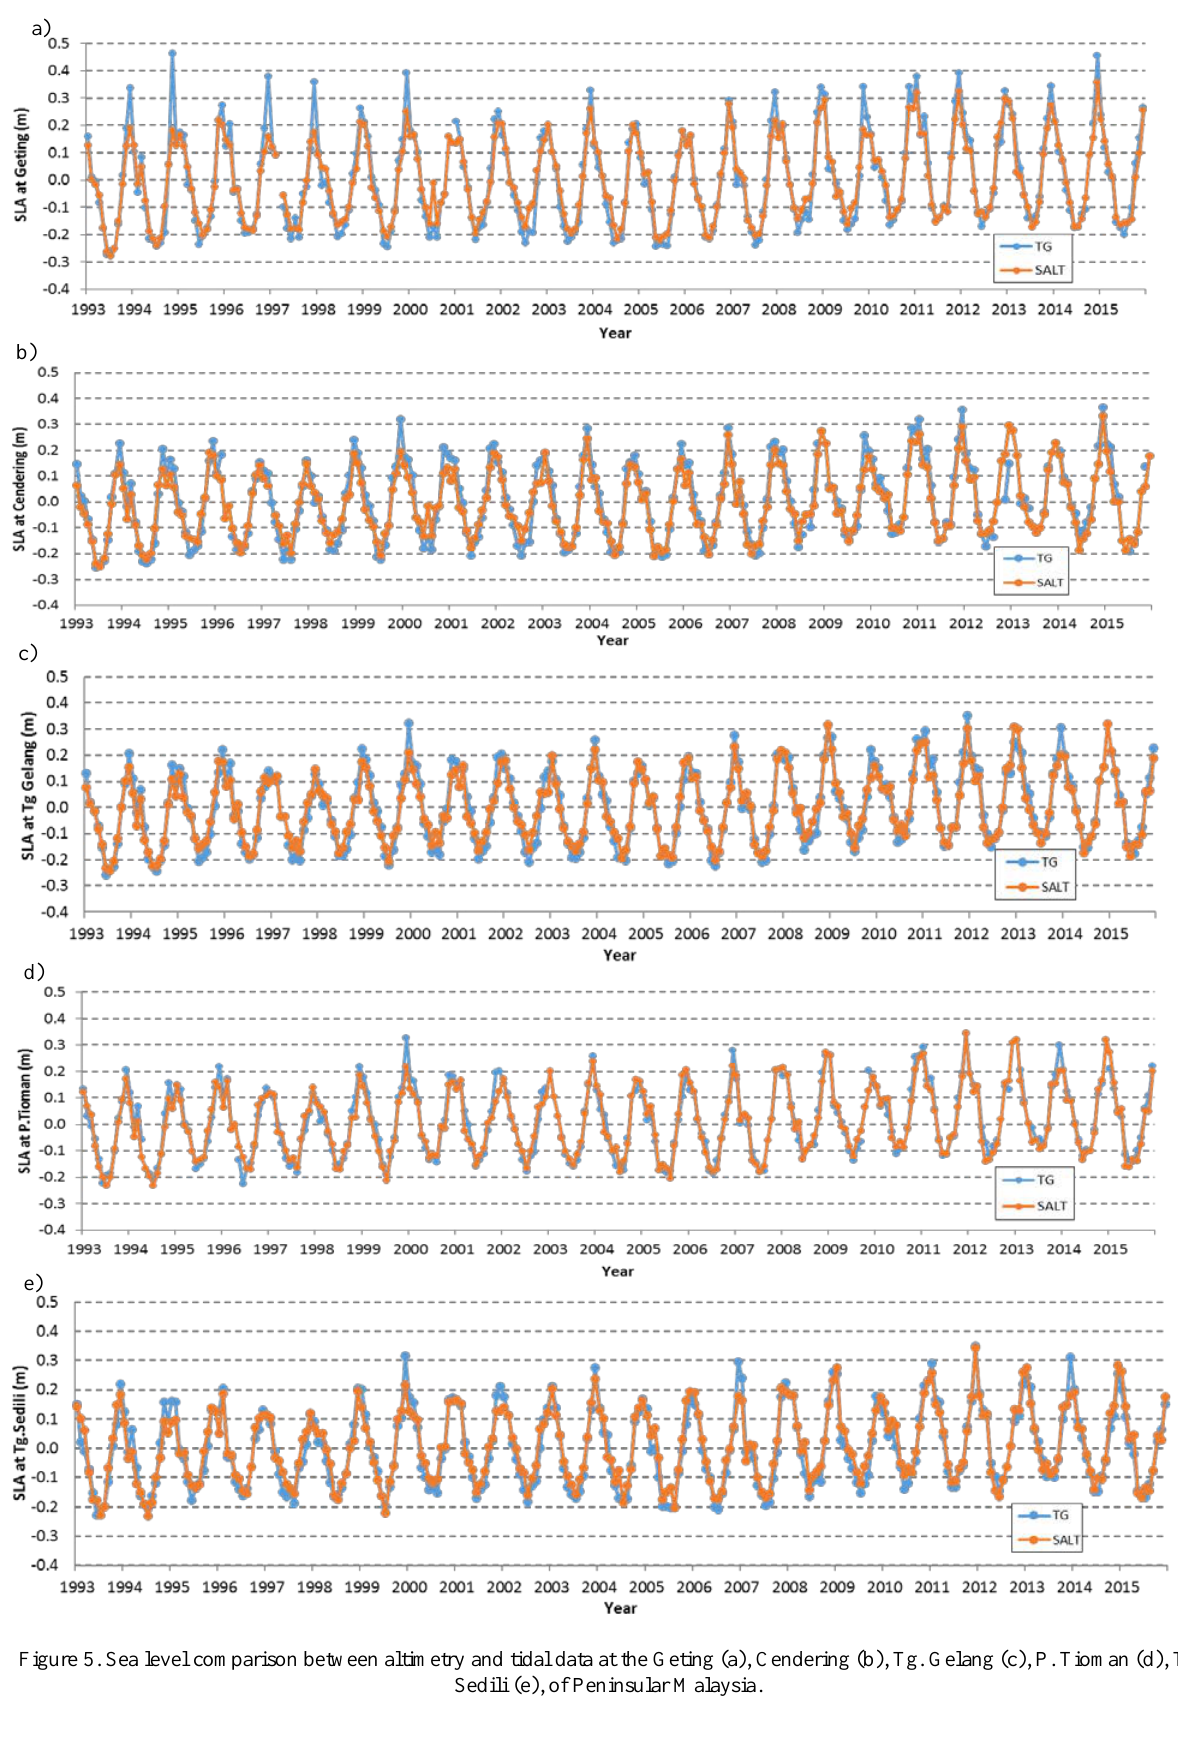
Figure 5. Sea level comparison between altimetry and tidal data at the Geting (a), Cendering (b), Tg. Gelang (c), P. Tioman (d), Tg Sedili (e), of